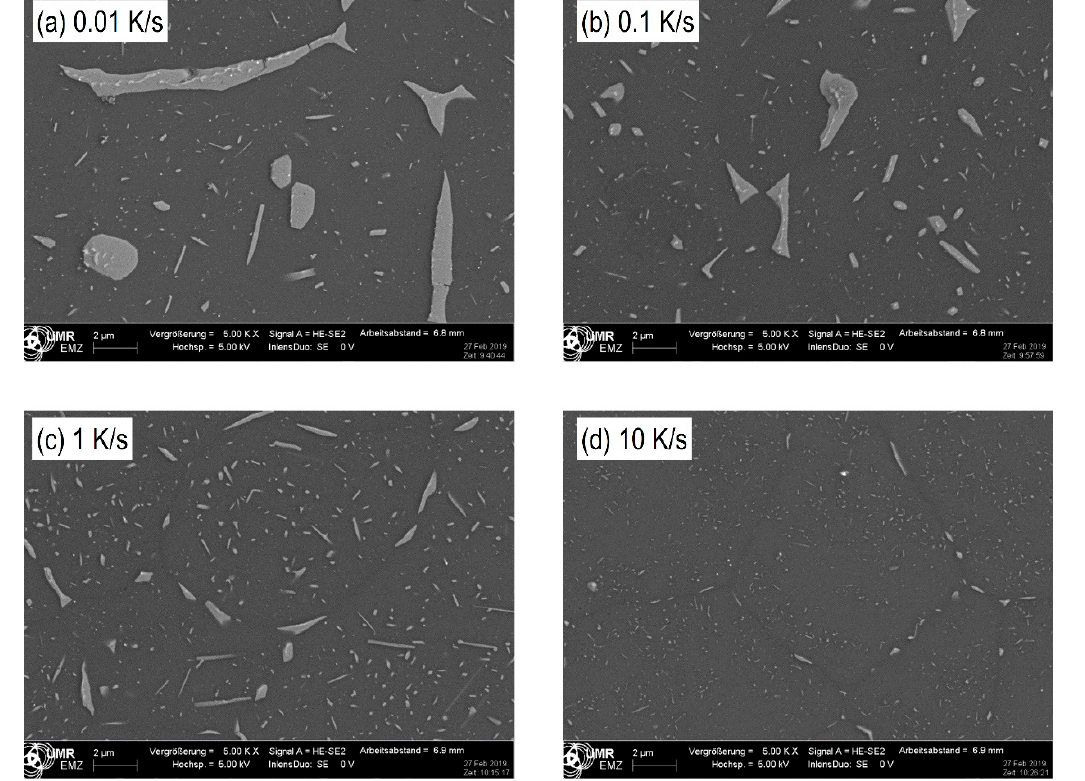
Figure 10. SEM-secondary electron images of alloy 7068: Cooling rates ( a ): 0.01 K / s; ( b ): 0.1 K / s; ( c ) 1 K / s; and ( d ) 10 K /